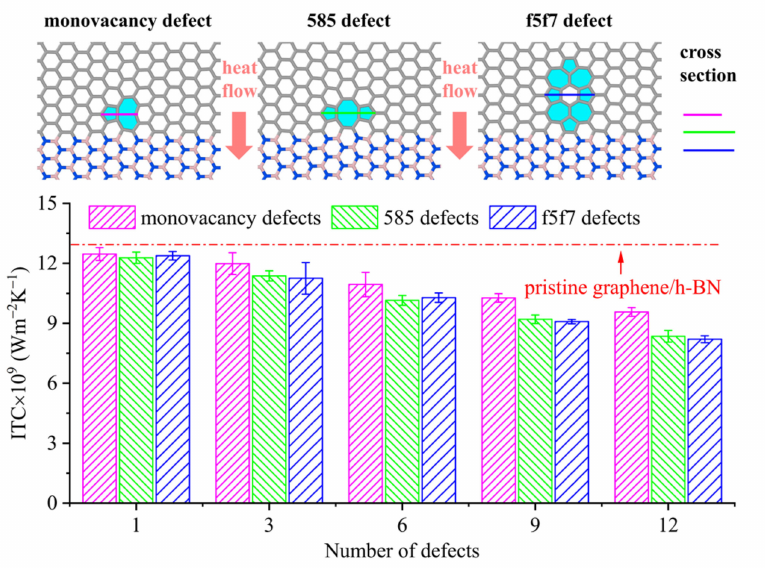
Figure 2. The ITC values of pristine graphene/h-BN and graphene/h-BN with different types and numbers of defects. The inset shows schematic diagrams and cross-sections of the different